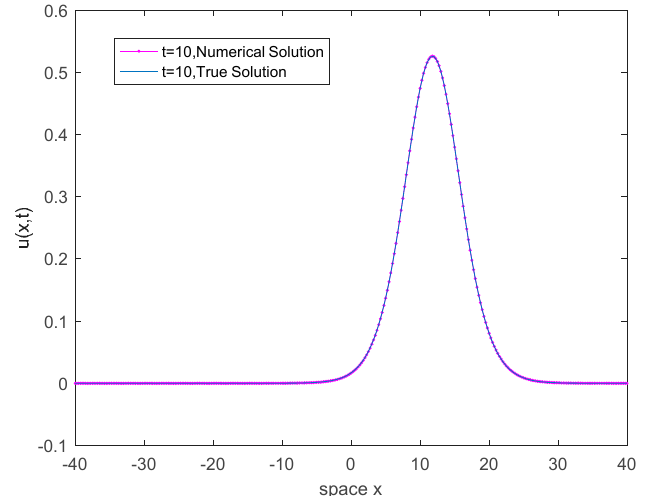
Figure 3. Numerical solution and exact solution with h = τ = 1/4, t = 10.